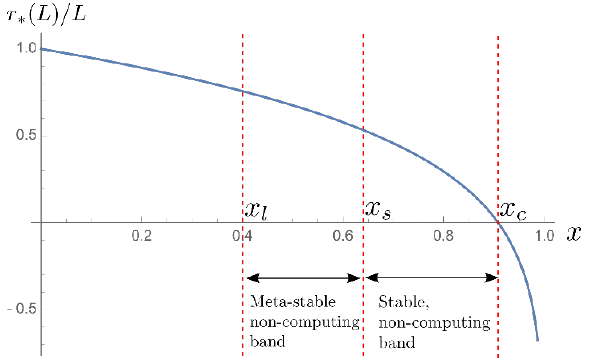
(cid:0) r (cid:1) d (cid:0) 2 . The band compatible with h L